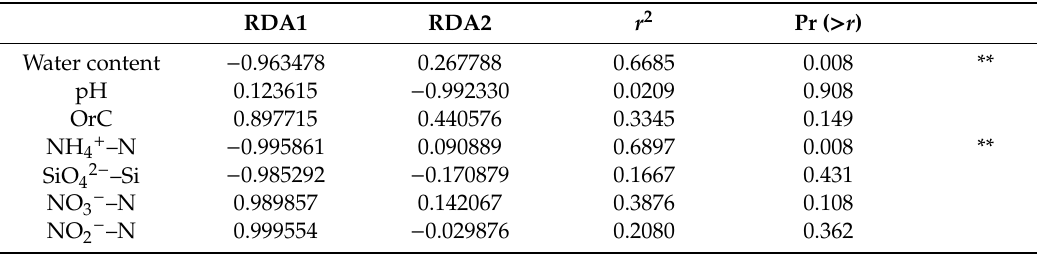
Table 3. A Monte Carlo permutation test of the relationship between environmental factors and archaeal community composition. RDA1